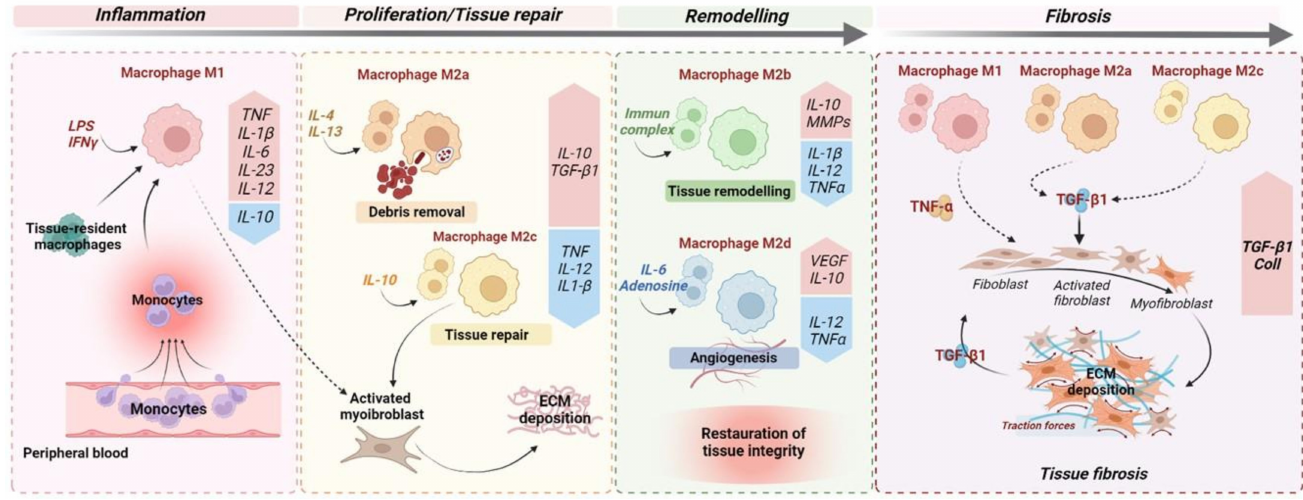
Figure 1. Monocyte and macrophage polarisation during wound healing and fibrosis. The optimal wound healing process could be dived into three distinct phases: inflammation, proliferation, and remodelling. After an acute injury (left), the first phase of wound healing is predominated by pro-inflammatory signals, including lipopolysaccharides (LPSs), that stimulate pro-inflammatory M1 macrophages but also the recruitment upon injury of circulating monocytes, which develop into pro-inflammatory M1 macrophages. In turn, M1 macrophages secrete high concentrations of pro-inflammatory cytokines, such as TNF and IL1- β . In the meantime, IL-4 and IL-13 induce M2a macrophages that clear apoptotic cells. During the proliferative phase, in response to anti- inflammatory cytokines/mediators, including IL-4 and IL-13, and the efferocytosis of apoptotic cells ensured by M2a macrophages, macrophages undergo functional reprogramming toward a pro- restorative phenotype: M2c. These, later, by secreting TGF- β 1, promote activation of myofibroblasts and extracellular matrix (ECM) deposition. During the last phase of wound healing, IL-10 is a key anti-inflammatory cytokine produced during the proliferative stage of repair that facilitates tissue remodelling by activating M2b macrophages which release metalloprotease matrix proteins (MMPs) to regulate ECM degradation. In addition, angiogenic response is promoted by M2d macrophage- releasing pro-angiogenic factors, including VEGF. Ultimately, the remodelling phase concludes with complete restoration of tissue. When chronic injuries occur (right), the persistence of M1, M2a, and M2c macrophage activation leads to fibrogenesis through the secretion of pro-inflammatory (TNF) and pro-fibrotic (TGF- β 1) cytokines, resulting in sustained myofibroblast activation and leading to excessive ECM